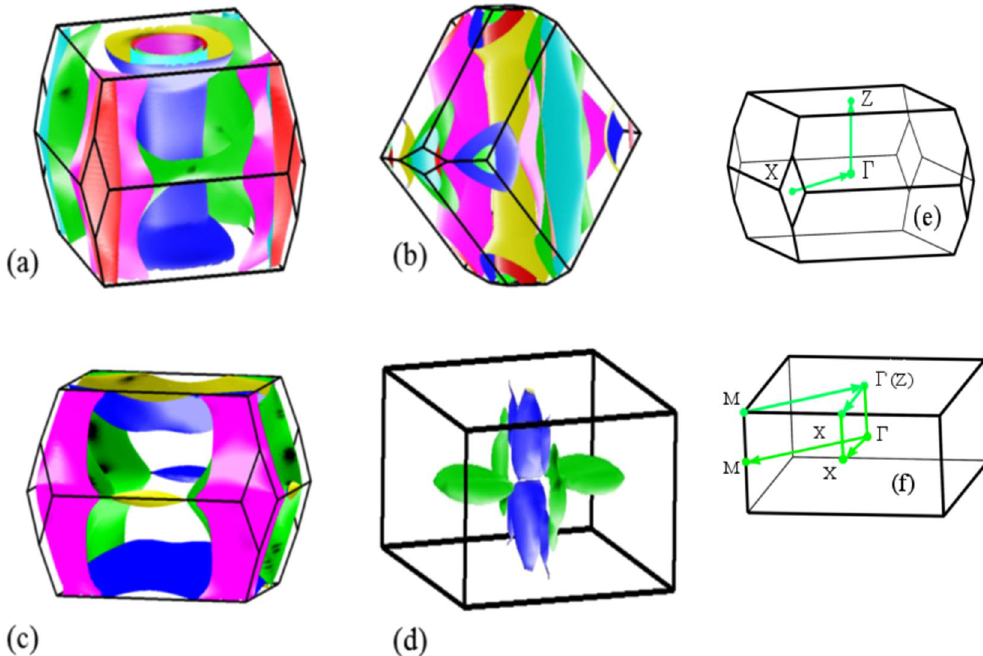
Figure 13. Fermi surfaces of CaFe 2 As 2 in ( a ) tetragonal, ( b ) orthorhombic ( c ) collapsed tetragonal (cT phase at P = 0.63 GPa) and ( d ) Antiferromagnetic orthorhombic structures. ( e ) and ( f ) show the Brillouin zone of the body centered tetragonal and tetragonal structures,